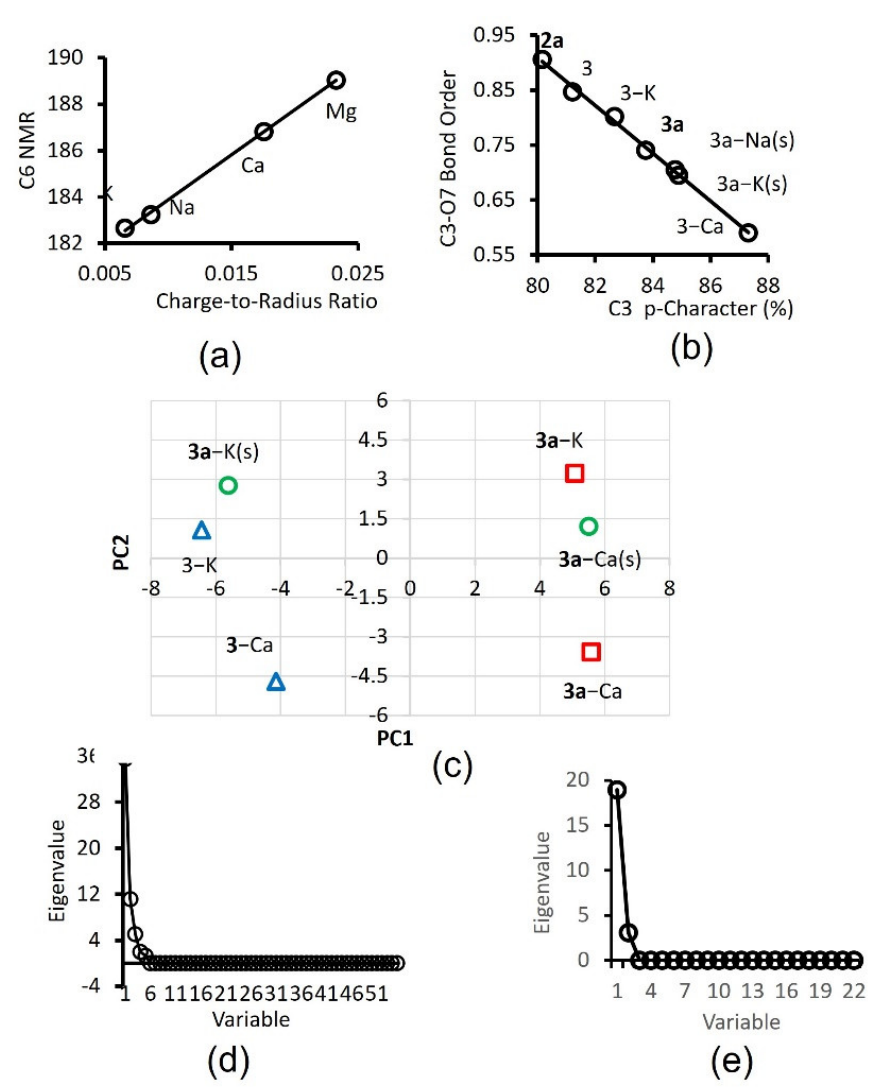
Figure 4. ( a ) C 6 NMR of 2 vs. cation charge-to-radius ratio in methanol, ( b ) C 3 -O 7 bond order vs. C 3 p-character for chromophore models, ( c ) PC2 vs. PC1 score plot, ( d ) computational Scree plot, and ( e ) experimental Scree plot.